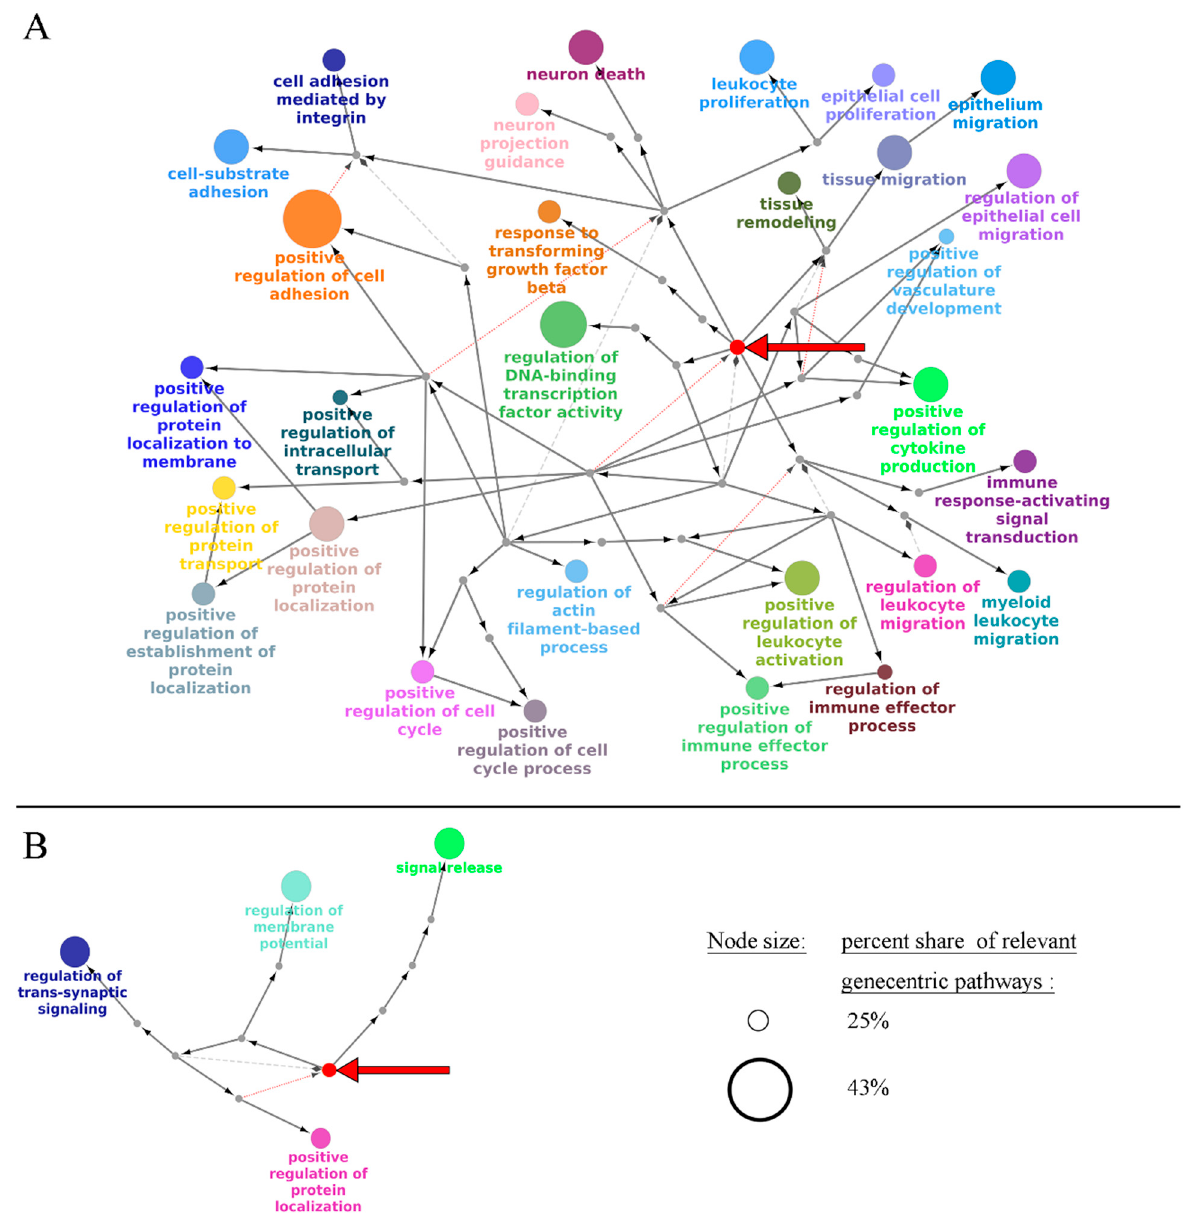
Figure 9. Gene Ontology tree (from null to third level) for gene-centric pathways linked with negative ( A ) and positive ( B ) prognoses in LGG. Bold red arrow shows a root node (null level of GO tree). Small grey nodes are parental nodes connecting a root node with significant terms of the third level. The size of a node reflects its adjusted p -value. Each group of terms is marked by a specific color.